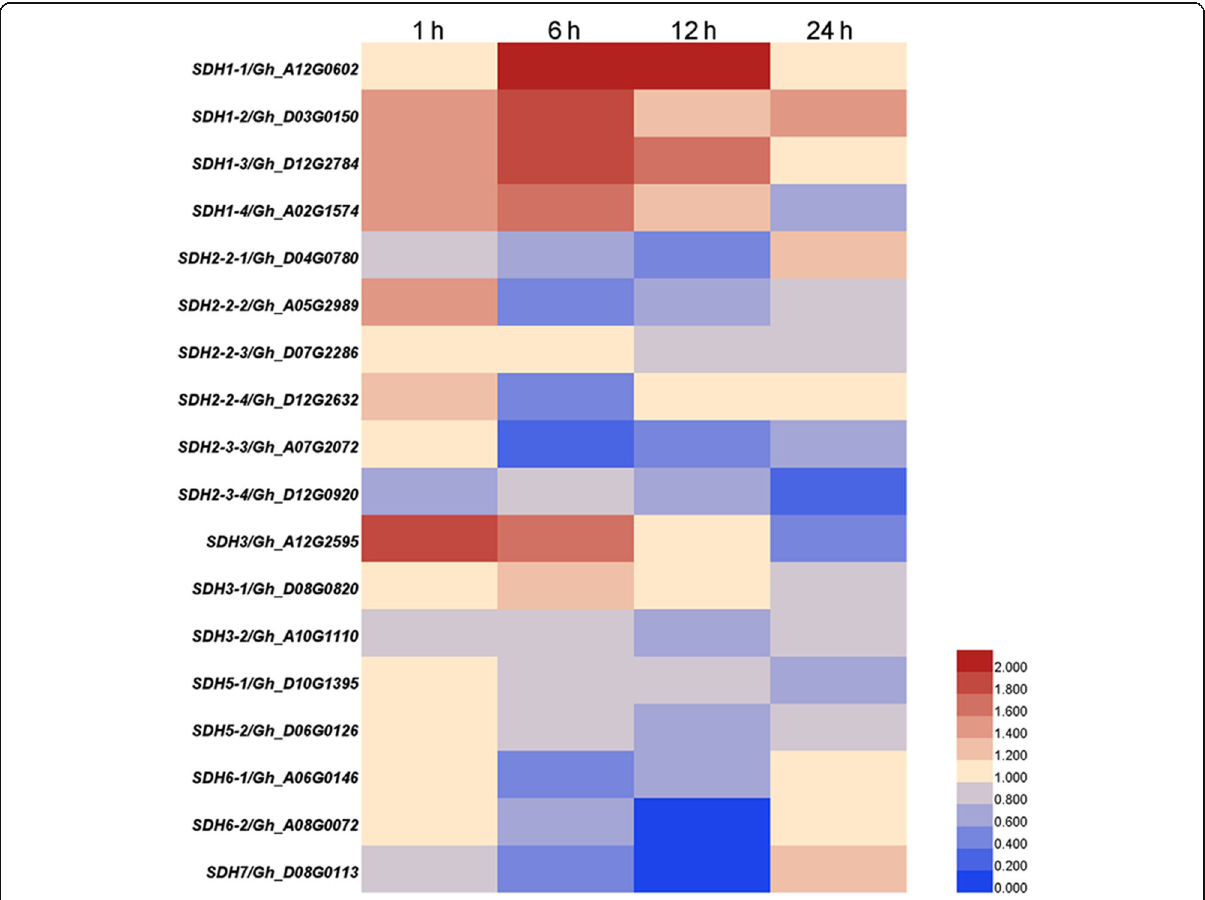
Fig. 1 Expression patterns of GhSDH1 – 1 under Verticillium dahliae stress treatment in cotton. The cotton ‘ Zhongzhimian 2 ’ were treated with Verticillium dahliae (Vd080) or an equal amount of sterile water, and the mock and treated roots were harvested at 0, 6, 12, 24 h post inoculation (hpi), respectively. The expression levels were determined by qRT-PCR, and the expression level of the mock control was normalized to ‘ 1